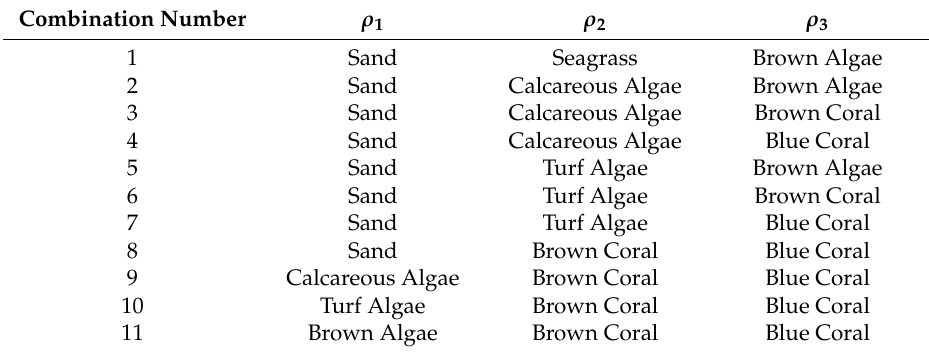
Table 2. The unique benthic endmembers used to parameterize the bottom reflectance ( ρ BRUCE ) of the BRUCE model. For each PRISM pixel, the BRUCE model iterates over each of the eleven combinations and selects the combination that generated the lowest optimization cost